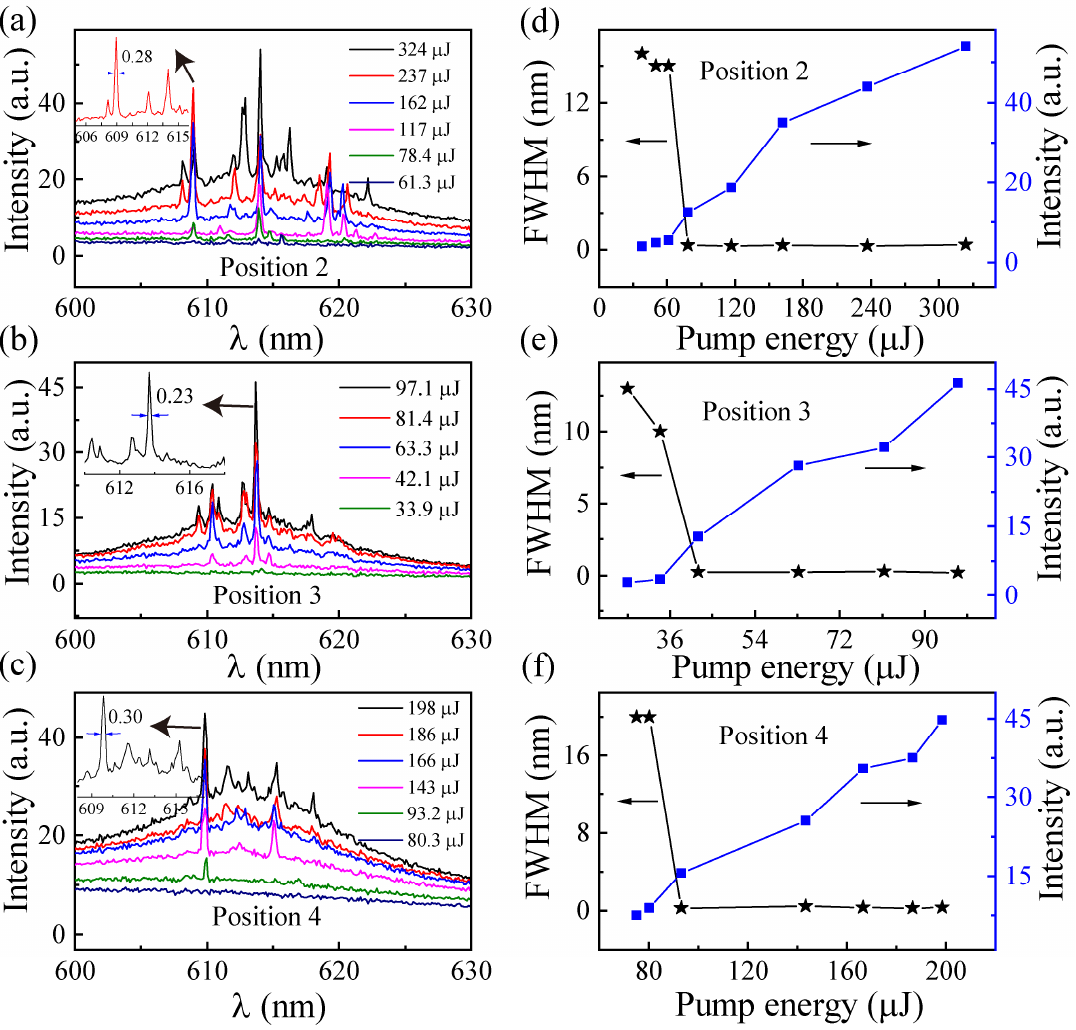
Figure 5. ( a – c ) Emission spectra as a function of pumping energy with different pumping positions for DCM/LC/Wing; ( d – f ) The emission intensity (blue squares) and FWHM (black stars) as a function of the pumping energy corresponding to ( a – c ).